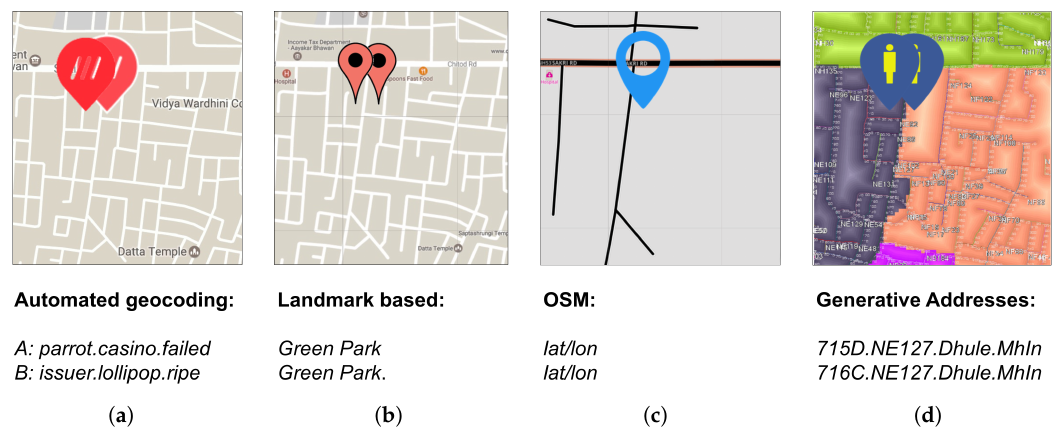
Figure 13. Comparison of Our Maps: ( a ) parrot.casino.failed of [1]; ( b ) Green Park of Google Maps; ( c ) absolutely no address other than latitude/longitude information in OpenStreetMap (OSM); and ( d ) full address as 715D.NE127.Dhule.MhIn of our